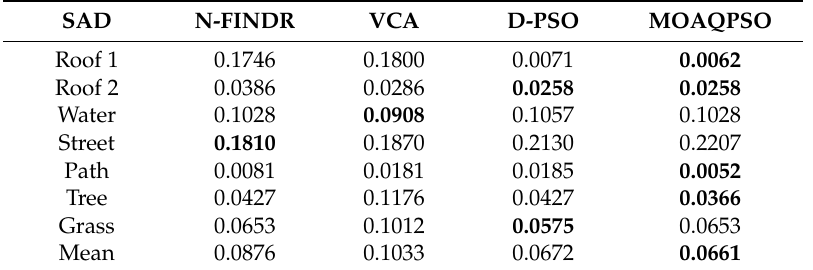
Table 7. Comparison between the SAD values of N-FINDR, VCA, D-PSO, and MOAQPSO. SAD N-FINDR VCA